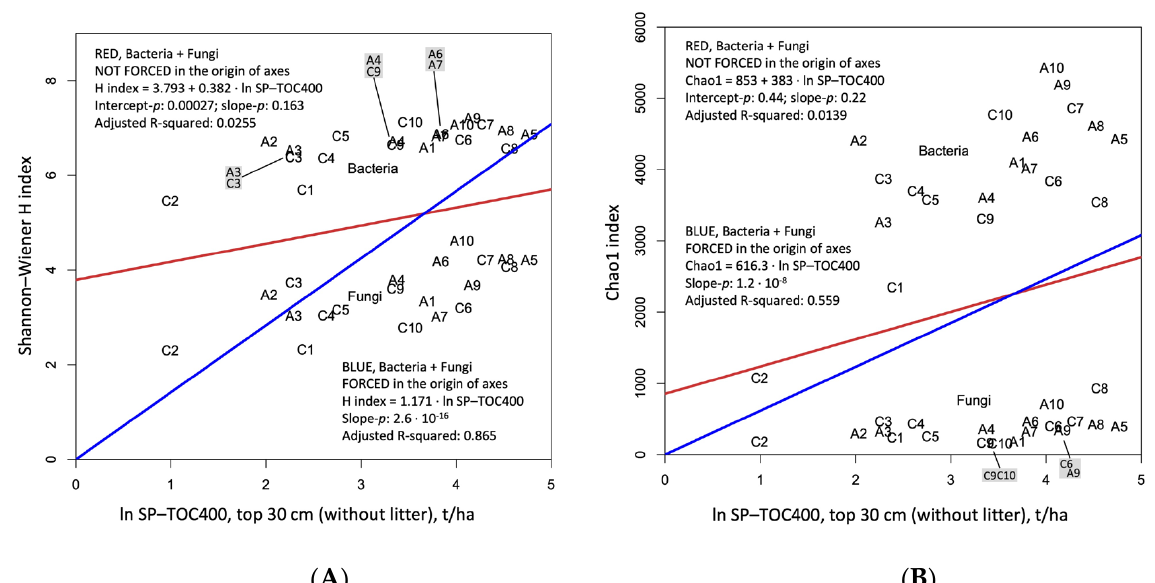
Figure 12. Linear regressions between ( A ) Shannon–Wiener or ( B ) Chao1 indices (OTUs of bacteria and fungi) and the logarithm (ln) of Skalar Primacs TOC400 (SP–TOC400) measured in Albarella and Caleri.